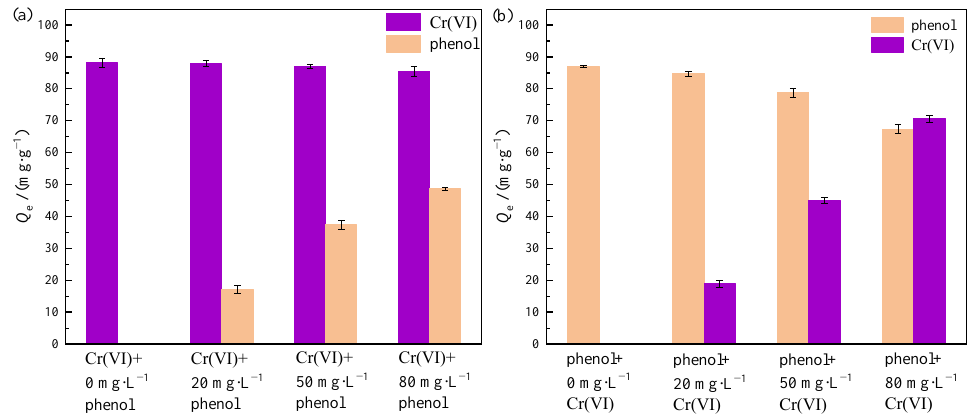
Figure 10. ( a ) The effect of the initial concentration of phenol on Cr( Ⅵ ) adsorption and ( b ) the effect of the initial concentration of Cr( Ⅵ ) on phenol adsorption.